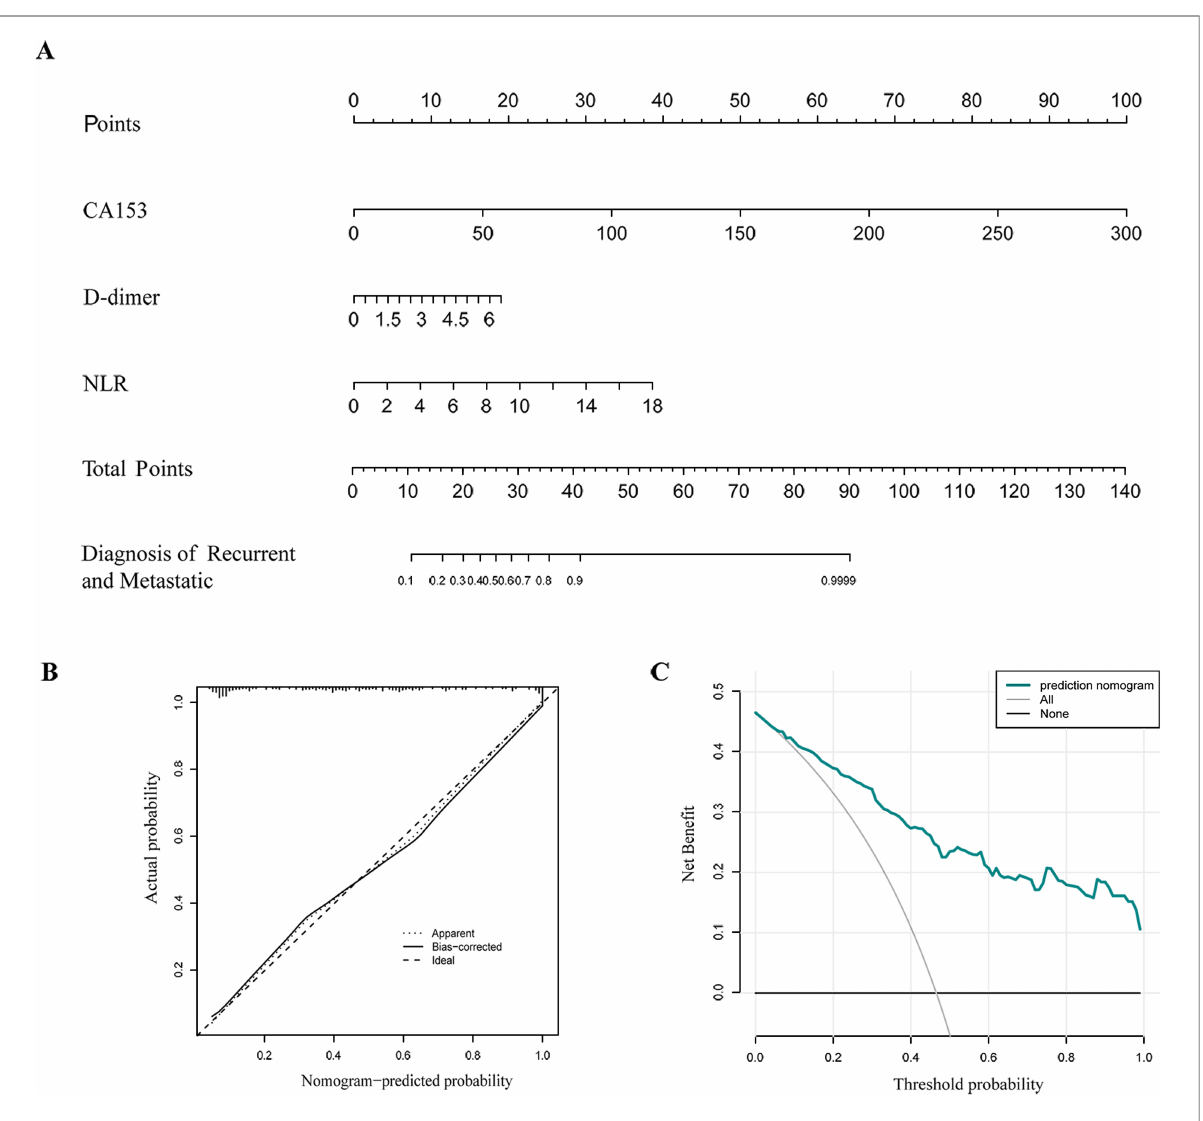
FIGURE 2 Nomogram for calculating the risk of recurrence and metastasis in breast cancer patients ( A ). Calibration curve ( B ). Decision curve analysis (DCA) ( C